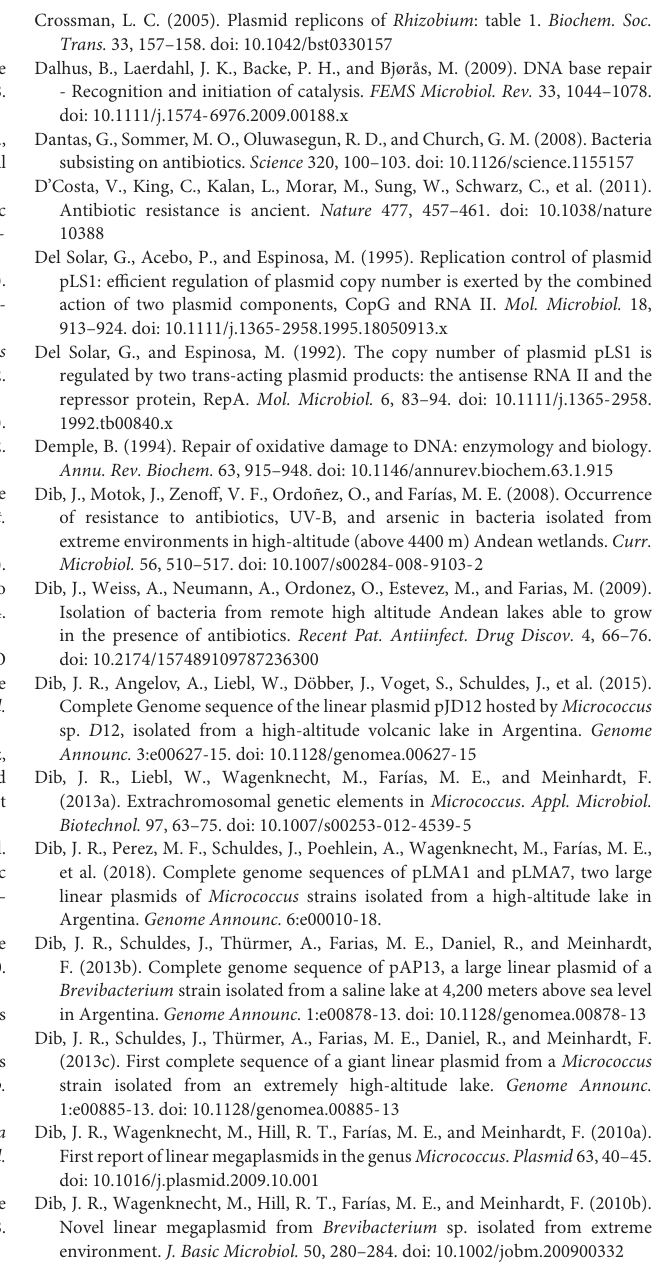
FIGURE S1 | Phylogenetic analysis of the Puquio de Campo Naranja plasmidome at bacterial class level. FIGURE S2 | Relative abundance of the archaeal phyla in the Puquio de Campo Naranja plasmidome.